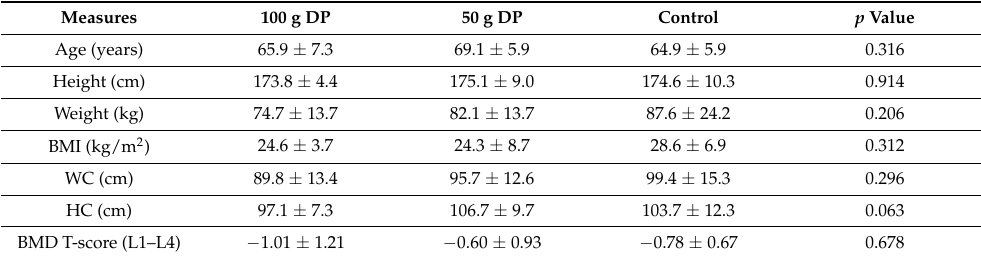
Table 1. Baseline characteristics between and among